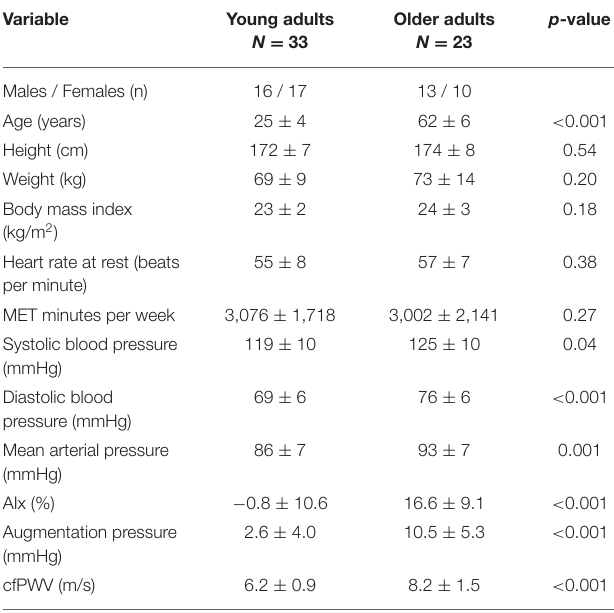
TABLE 1 | Characteristics of